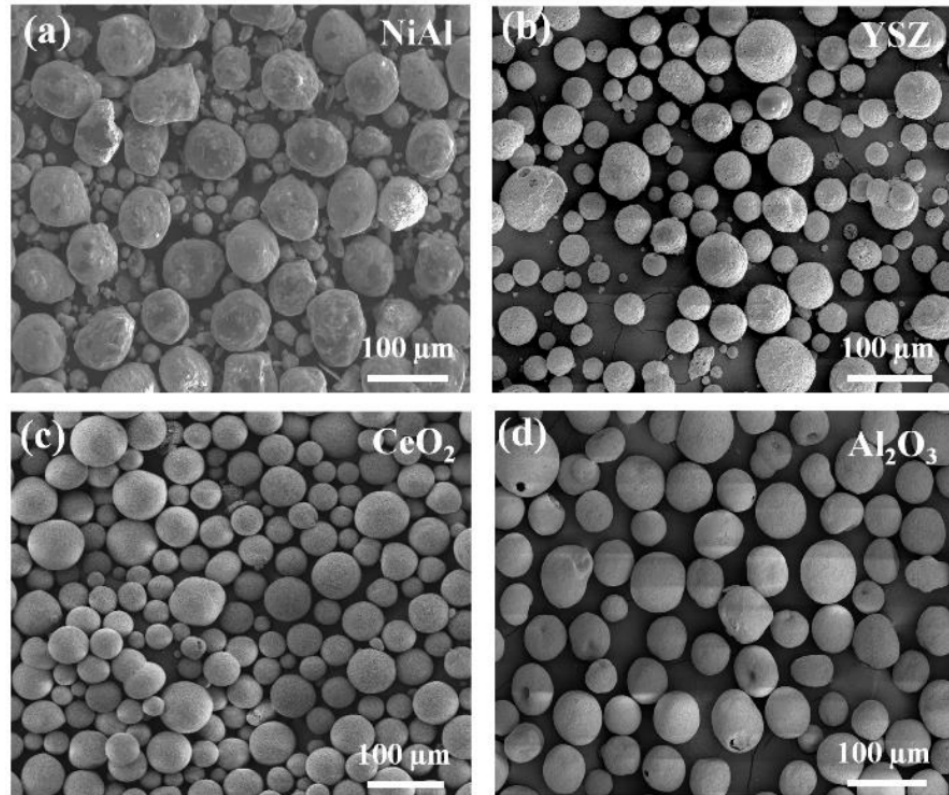
Figure 6. FE-SEM images show the morphology of the ( a ) NiAl, ( b ) YSZ, ( c ) CeO 2 and ( d ) Al 2 O 3 feedstock powder.